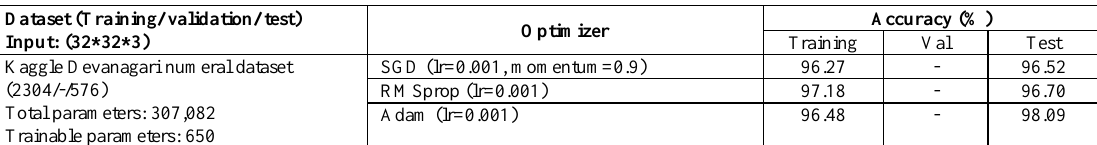
Table 2. Fine tuning on Kaggle Devanagari numeral